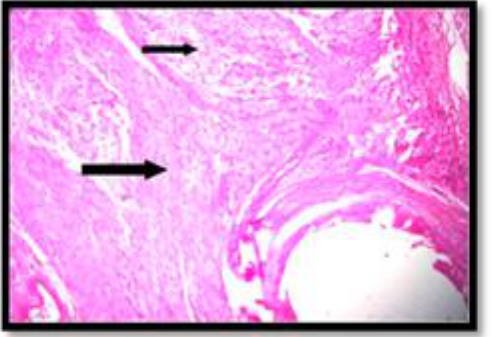
Figure, 15: UBM-treatment group at 8th week post implantation, shows that host tissue (long arrow) exhibited peripheral aggregation of MNCs (short arrow) forming granulomatous like reaction (H&E stain, 200X)